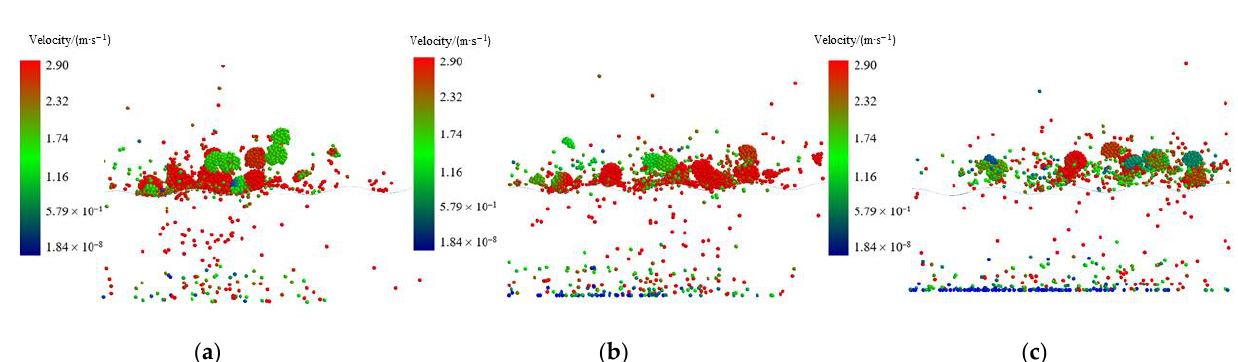
Figure 12. Velocity graph of frass agglomerates at an amplitude of 0.012 m. ( a ) t = 1.8 s. ( b ) t = 2.2 s. ( c ) t = 2.6 s.